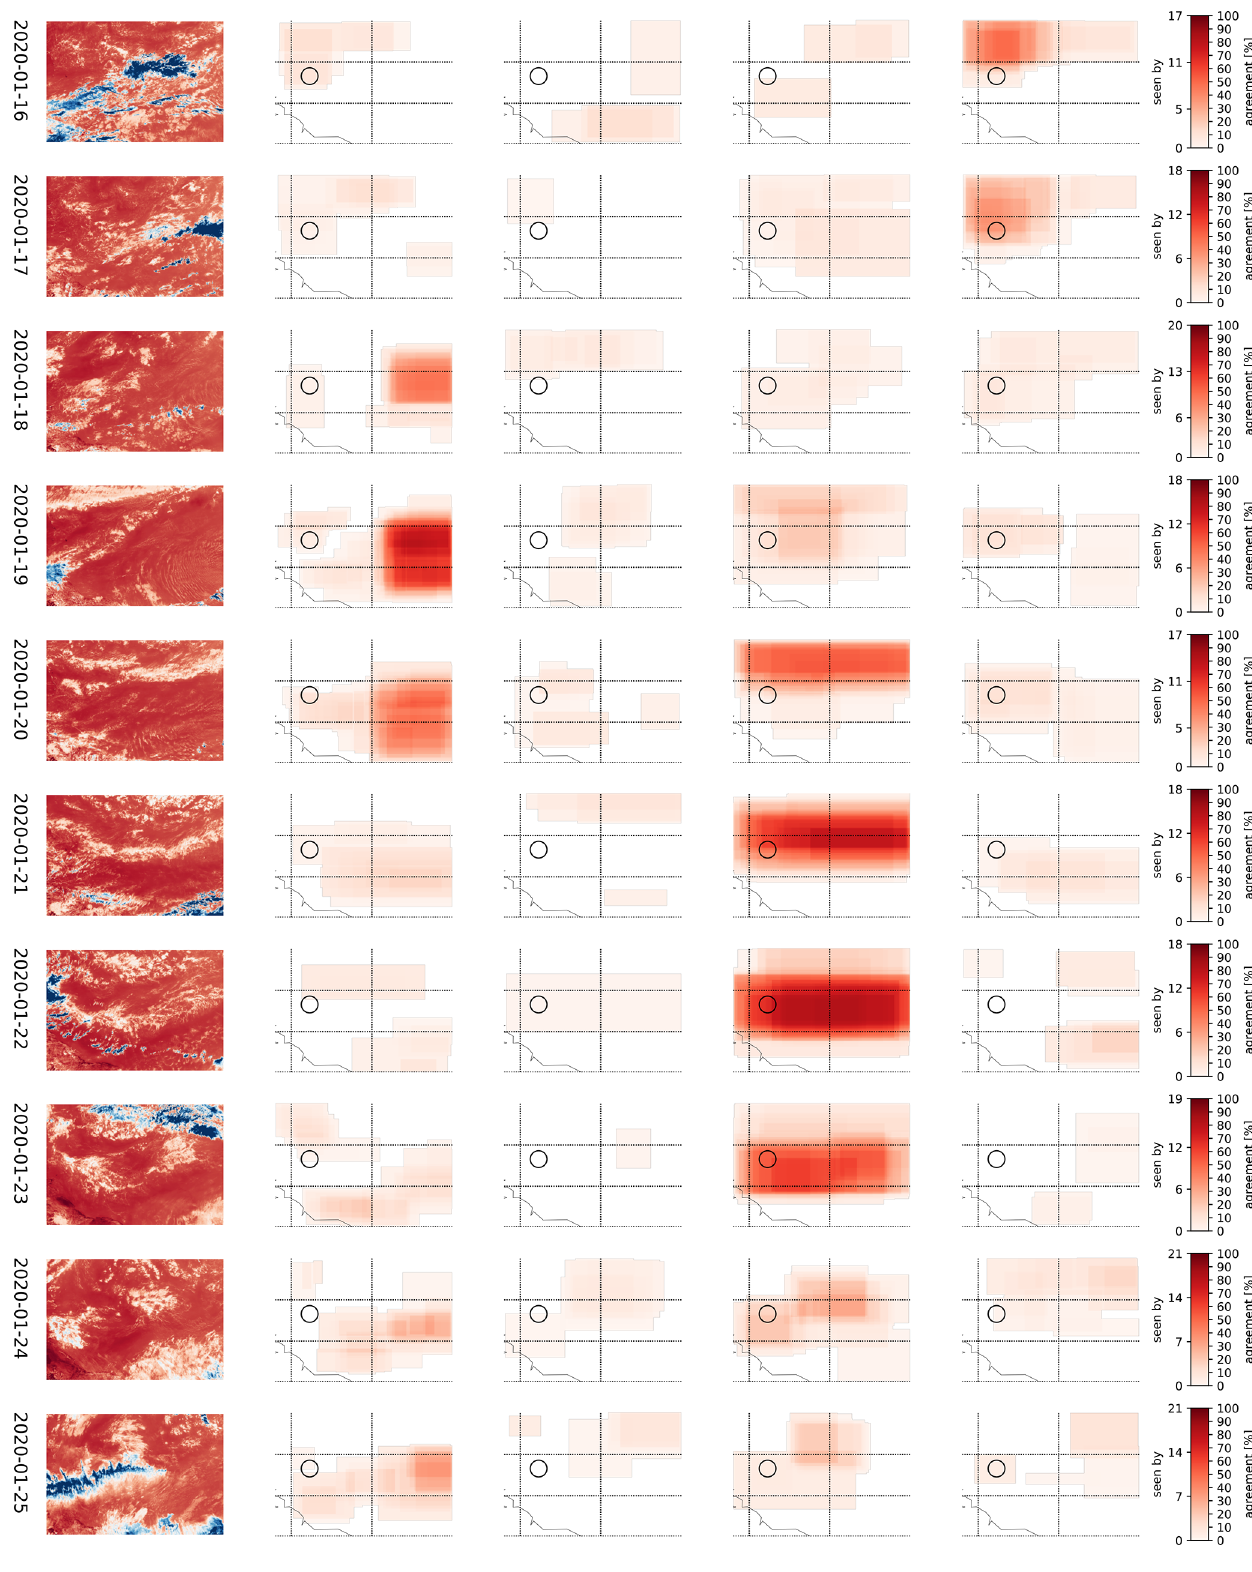
https://doi.org/10.5194/essd-14-1233-2022 Earth Syst. Sci. Data, 14, 1233–1256,